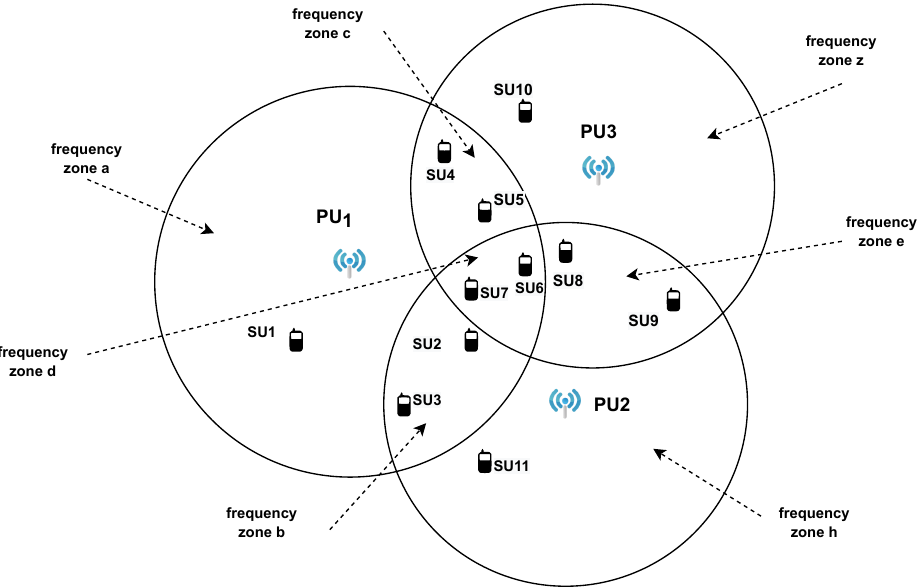
Figure 3. Cognitive radio network of three PUs with overlapping spectrum. According to these sets, SU1 is located at the coverage area of PU1 and is interested in frequency bands a , b , c , d . SU4 is in the range of PU1, PU2, and PU3, and is interested in all frequency bands. SU2 is in the coverage of PU1 and PU2 and is interested in all zones except for z . Based on the common interest sets C j , j = 1, 2, . . . , J with J = 6, we